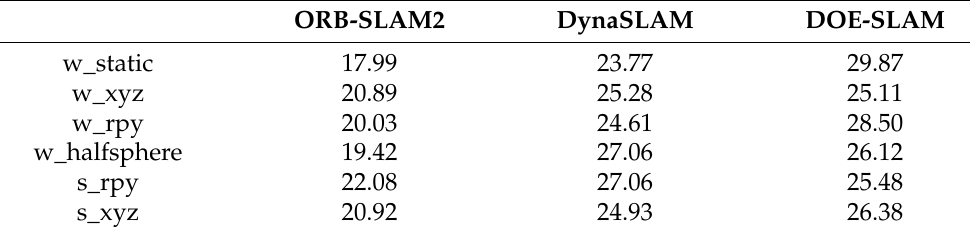
Table 5. Comparison of the average computation time (ms) in selected TUM datasets.